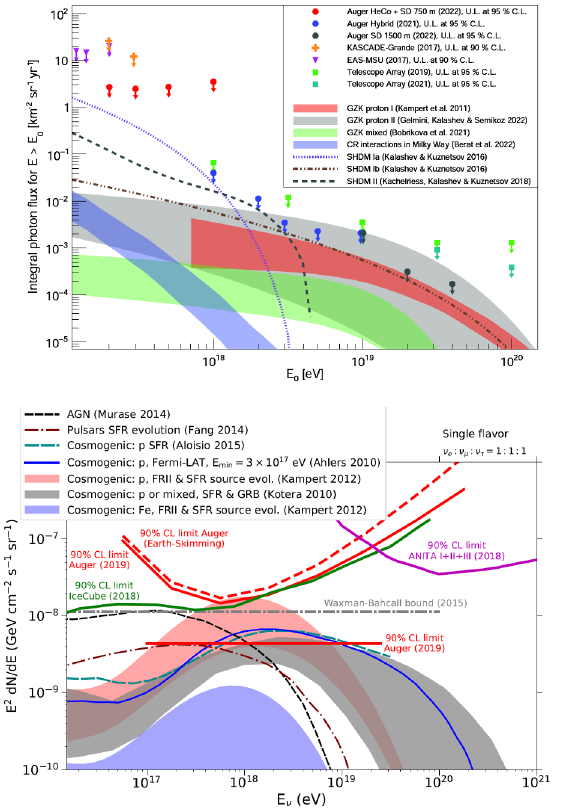
Figure 1. Upper limits on the cosmogenic photons (top) and neu- trinos (bottom) fluxes compared to limits from other experiments and to model predictions ( [5, 6] and references therein).